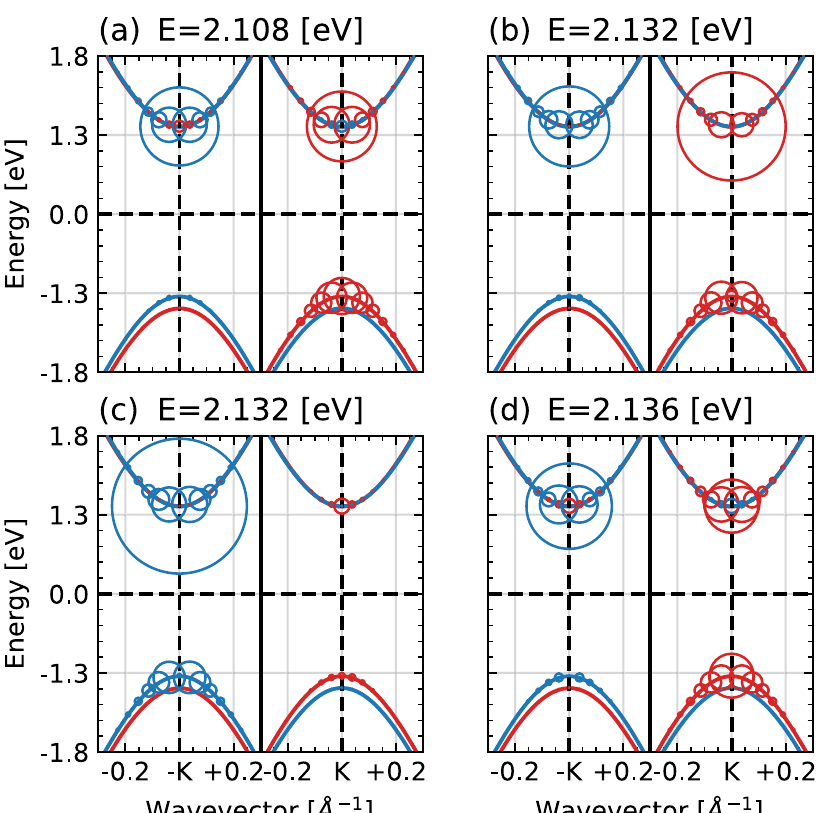
Fig. 3 Charge density distributions. We show the distribution of various τ s z = + 1/2 trionic states at E F = 10.56 meV: a -- trion state (attractive polaron), b -- indirect exciton state, c -- direct exciton state (repulsive polaron) and d -- potential excited trion state. The radii of the circles are proportional to the distribution of the charge density of the three-particle state. Energies of each state are indicated in the title of panels. All four states are bright. Both excitons states exhibit Pauli blocking effect, which is observable at the top of the valence band.